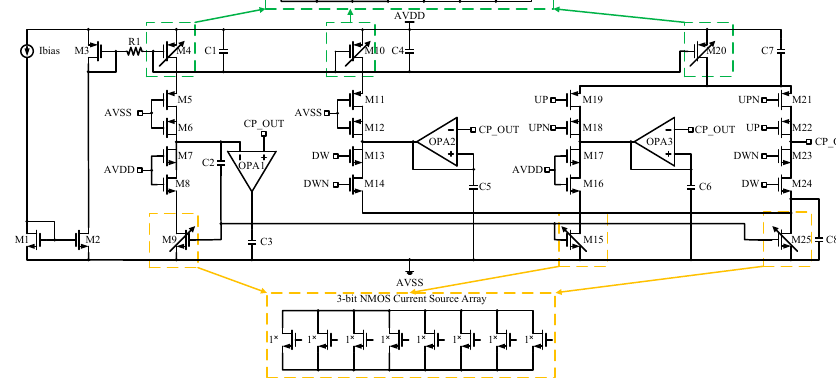
Figure 3. CP topology.